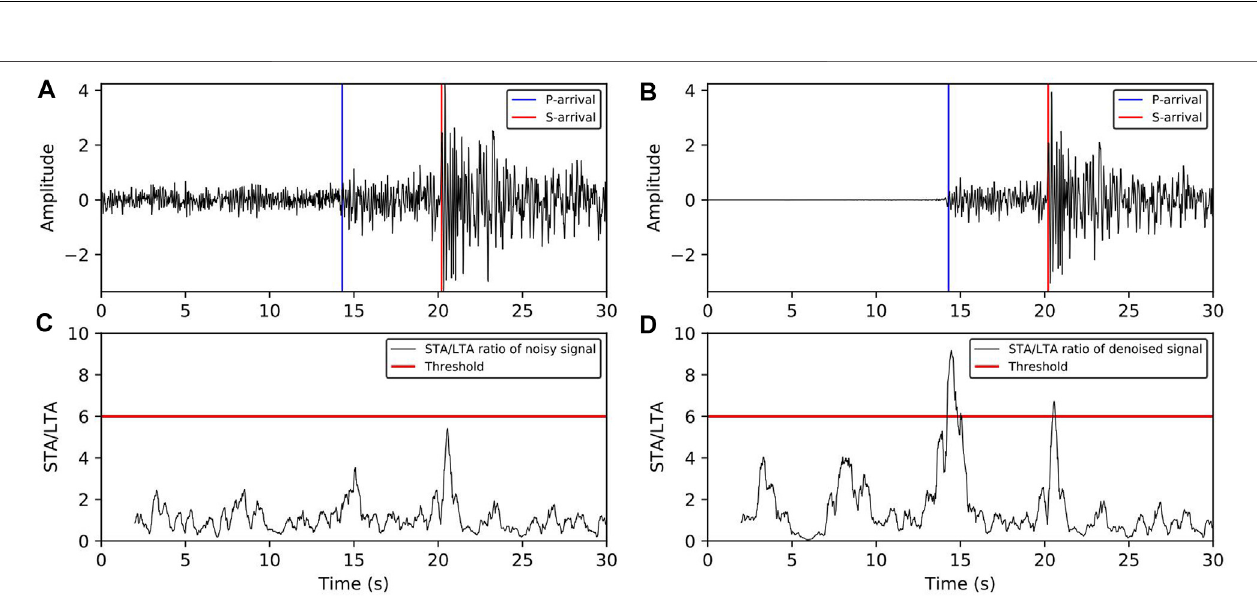
FIGURE15| Comparisonoftheseismicphaserecognitioneffectbeforeandafterdenoising; (A) seismicsignalbeforenoisereduction; (B) signalafterDnRDBnoise reduction; (C) the eigenfunction of the STA/LTA before noise reduction; (D) the eigenfunction of the STA/LTA after noise reduction.